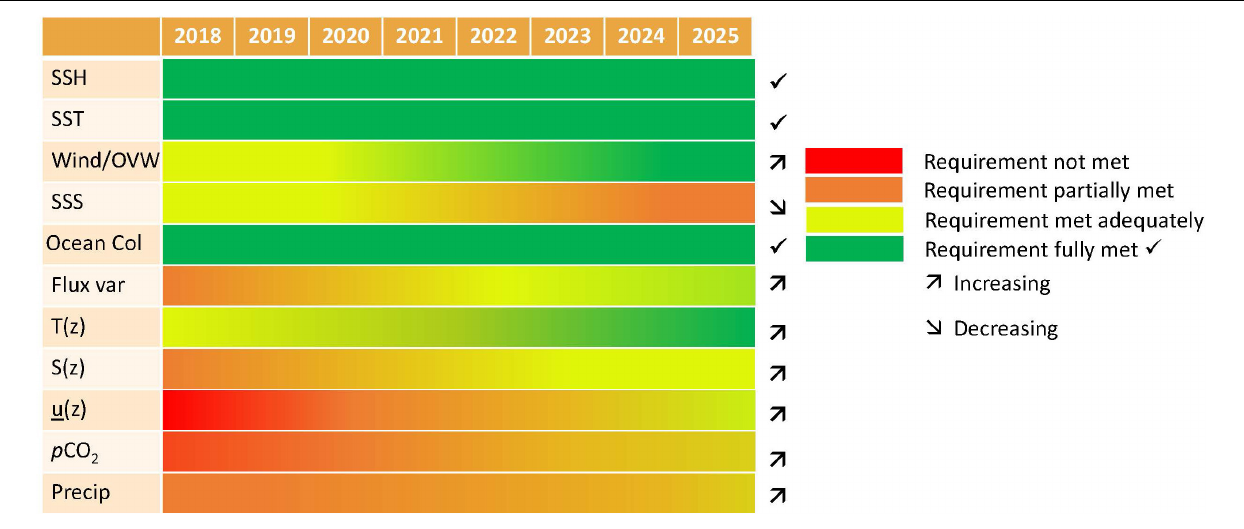
FIGURE 8 | Status of the observing system in the tropical Pacific with respect to the main variables and requirements as set out in Section 3.4 of Cravatte et al. (2016). The variables are SST, sea surface height (SSH), wind/ocean vector wind, SSS, ocean color, heat and freshwater flux, vertical temperature, salinity and velocity, p CO 2 and precipitation. The assessment of status is broad and not at the detailed level. The four status levels are (a) red: requirement not met or only in part; (b) gold: requirement partially met (useful/threshold in the language of WMO Rolling Review of Requirements